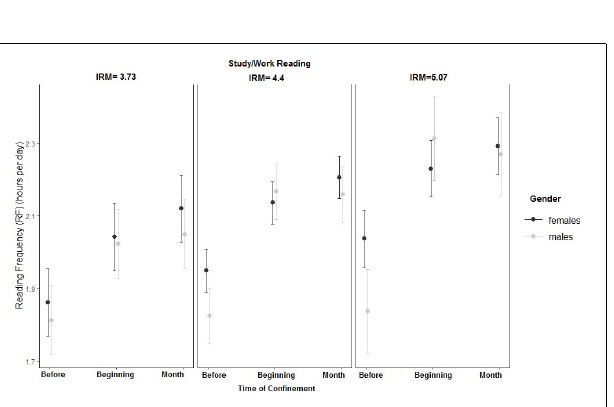
FIGURE 4 | Interaction between reading frequency (RF), gender, and intrinsic reading motivation (IRM) for Study/Work